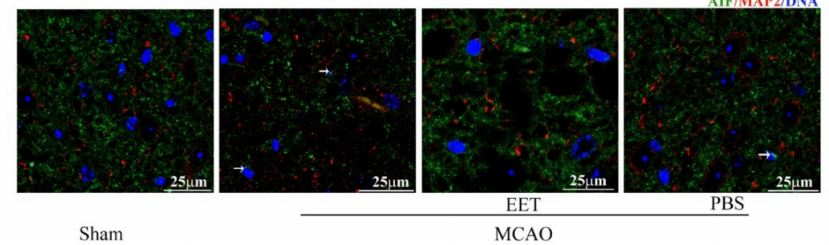
Figure 4. AIF nuclear translocation was detected in mouse brains with immunofluorescence method in cerebral cortical neurons induced at 22 h after MCAO and reperfusion. Arrows point to the nuclear translocation of AIF. 14,15-EET pretreatment reduced the nuclear translocation of AIF at 22 h after middle cerebral artery occlusion and reperfusion in